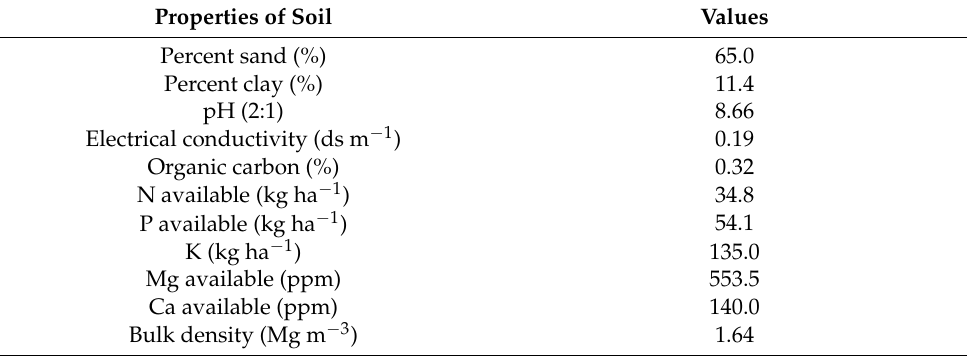
Table 1. Major properties at 0–15 cm soils of investigational location.